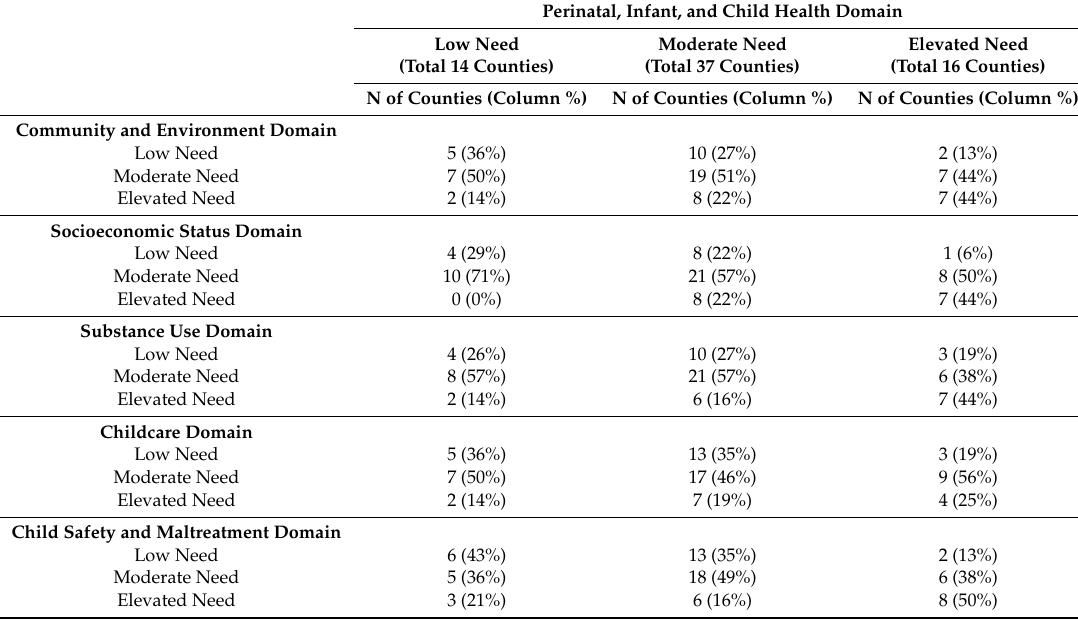
Table 4. The correlation between elevated need on Perinatal, Infant, and Child Health Domain and the need indices on the other 5 domains, among 67 counties in Pennsylvania.